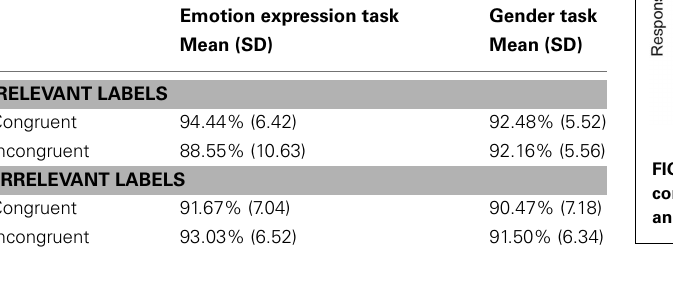
Table 2 | Means and SDs of participant accuracy.